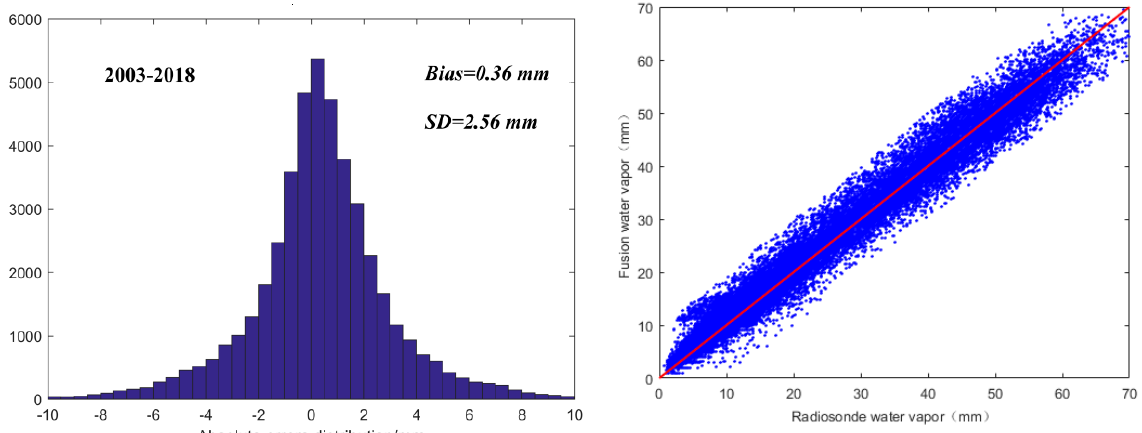
Table 2 shows that the RMSE and SD of the water vapor fusion results are better than 3 mm. Positive deviations smaller than 0.6 mm were observed for Bias and those better than 2 mm were observed for MAD, while R was stronger than 0.98. An analysis of the error distribution of remotely sensed fused water vapor and radiosonde water vapor from 2003 to 2018 was carried out to visually illustrate the comparison over the past 16 years. As shown in Figure 7, the errors presented a normal distribution, with a slight bias toward positive values. The overall estimated Bias was 0.36 mm (95% confidence interval: 0.33–0.38 mm), and the SD was 2.56 mm (95% confidence interval: 2.54–2.58 mm). A high correlation was found between the two water vapor datasets.